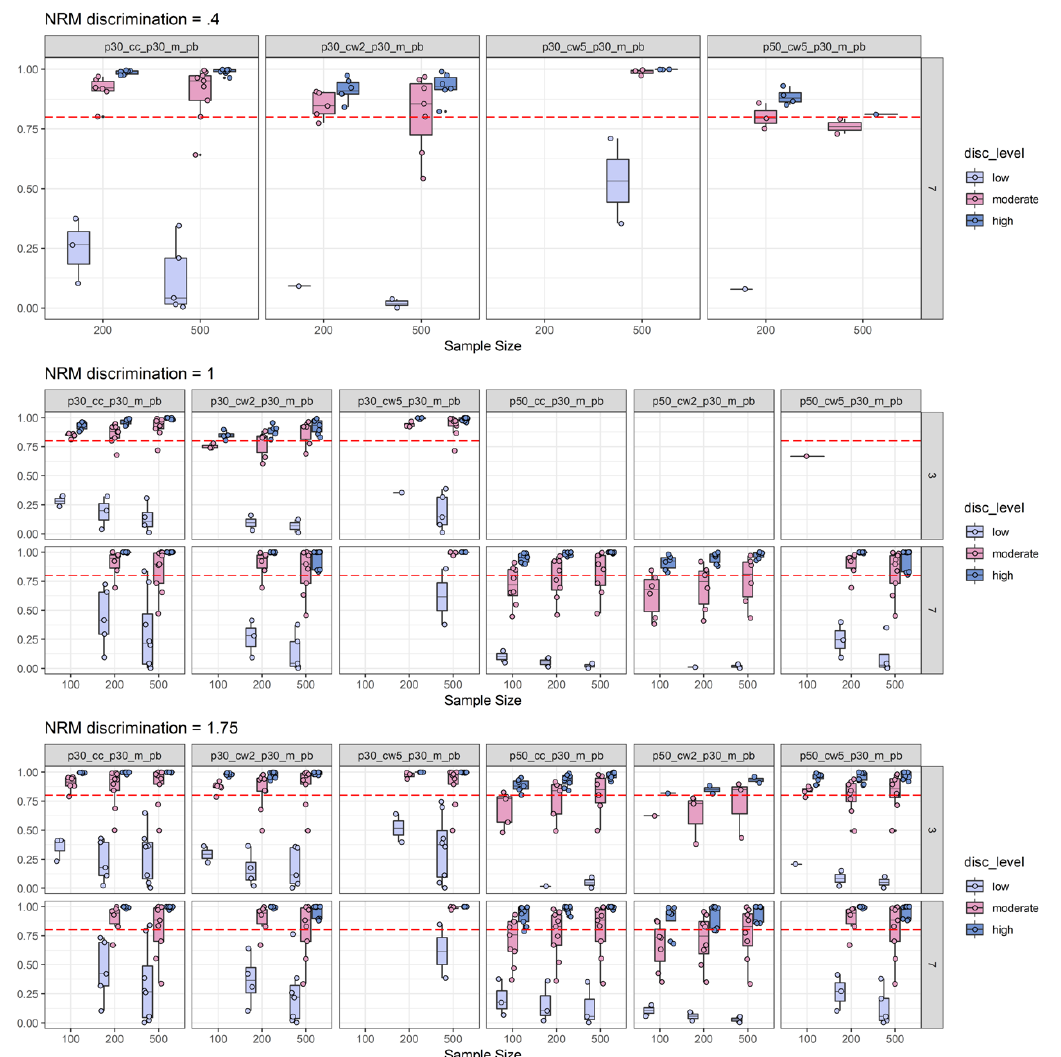
Figure A4. 2PL-discrimination split of empirical power analysis: Depiction of the empirical power (y-axis) under the boundary condition that the average PB DC is smaller than − 0.30. Power is depicted as a function of NRM discrimination, sample size (x-axis), number of distractors, 2PL-discrimination, and discrimination effect sizes combined with effect size thresholds (p30_cc_p30_m_pb = canonical correlation with a 0.30 threshold; p30_cw2_ p30_m_pb = Cohen’s ω based on two ability groups with a